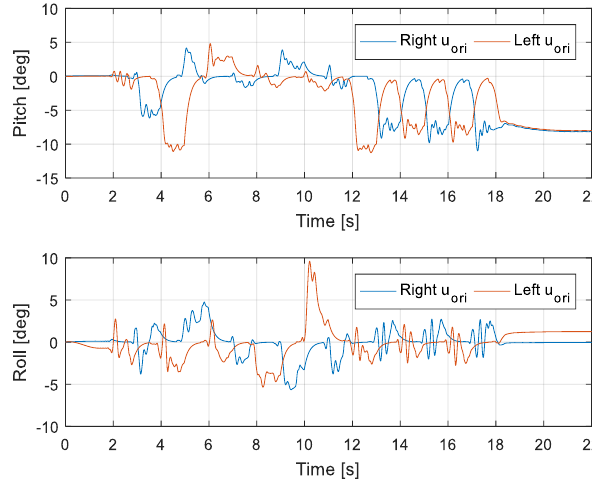
Figure 19. Foot orientation along x (roll) and y (pitch) axes.